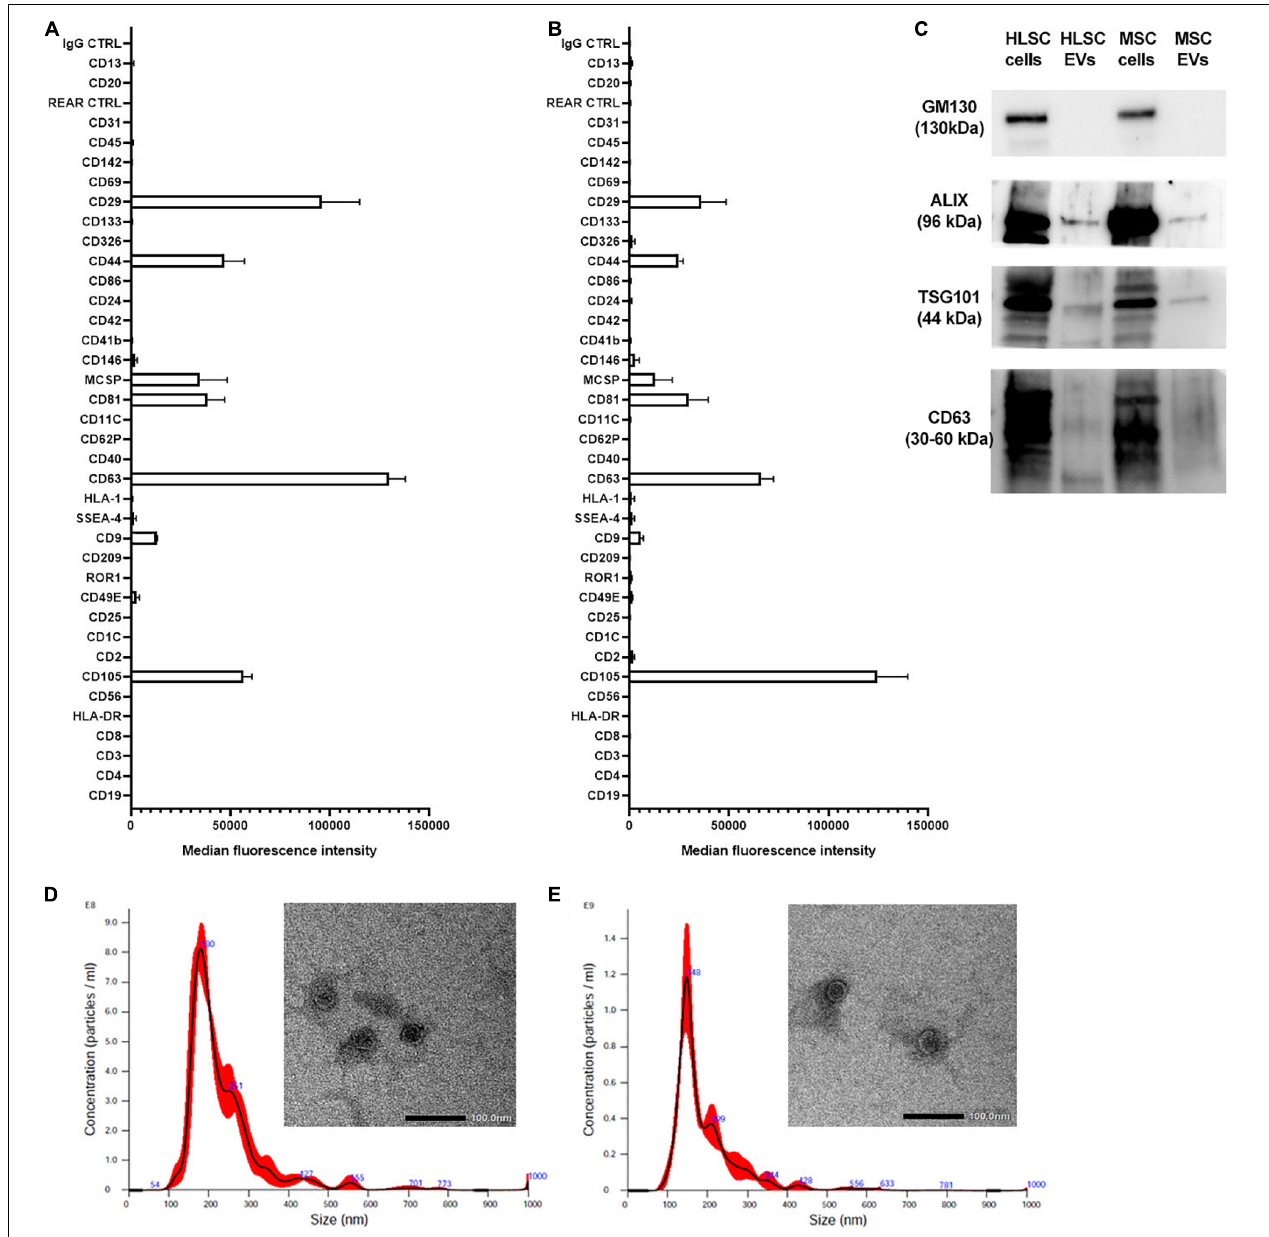
FIGURE 1 | Characterization of HLSC-EVs and MSC-EVs. (A,B) The surface molecular profile of HLSC-EVs (A) and MSC-EVs (B) was determined using a multiplex bead-based flow cytometry assay with 39 multiplexed populations of dye-labeled antibody-coated capture beads. The graph shows a quantification of the median APC fluorescence values for all bead populations after background correction (medium control values subtracted from measured EV values) of three different HLSC-EV and MSC-EV preparations. No statistically significant differences were observed among the different EV preparations. (C) Representative western blot analysis of exosomal markers (ALIX, TSG101, and CD63) in EVs. The cis -Golgi marker GM130, not expressed in EVs but present in cells (HLSCs and MSCs), was used as negative control. (D,E) Representative graphs of Nanoparticle Tracking Analysis showing EV size distribution, and representative micrographs of transmission electron microscopy of HLSC-EVs (D) and MSC-EVs (E) . EVs were negatively stained with NanoVan (scale bar, 100 nm; magnification, 50,000 ×